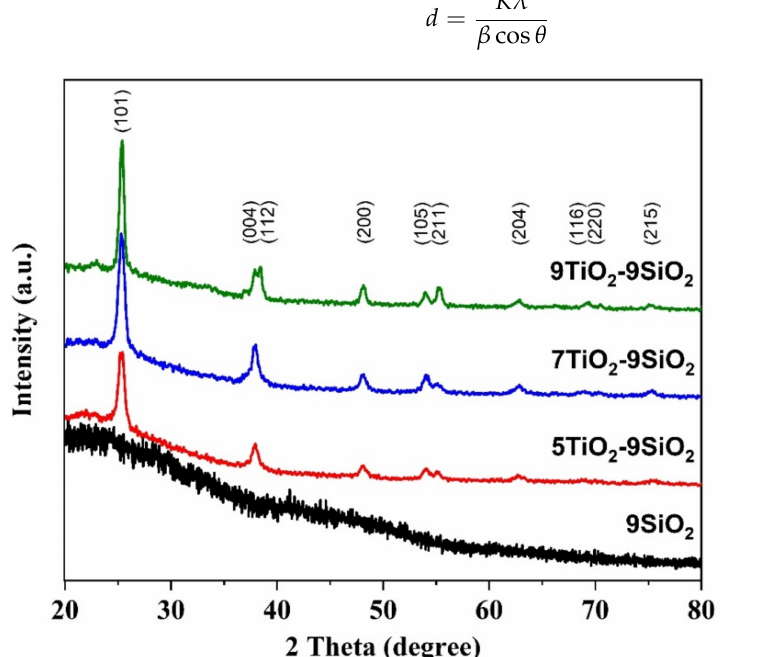
Figure 2. X-ray diffraction patterns for samples of TiO 2 over SiO 2 annealed. The tetragonal phase is linked to thin films of TiO 2 that correspond to the (hkl)